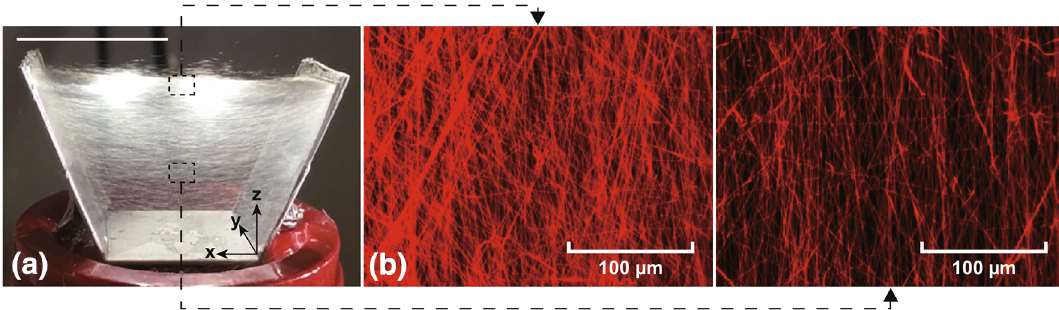
Fig. 2 a 3D nanofiber scaffold obtained by the double-bevel collector. Scale bar represents 20 mm. Fluorescent nanofibers at the b top section and c bottom section of the scaffold